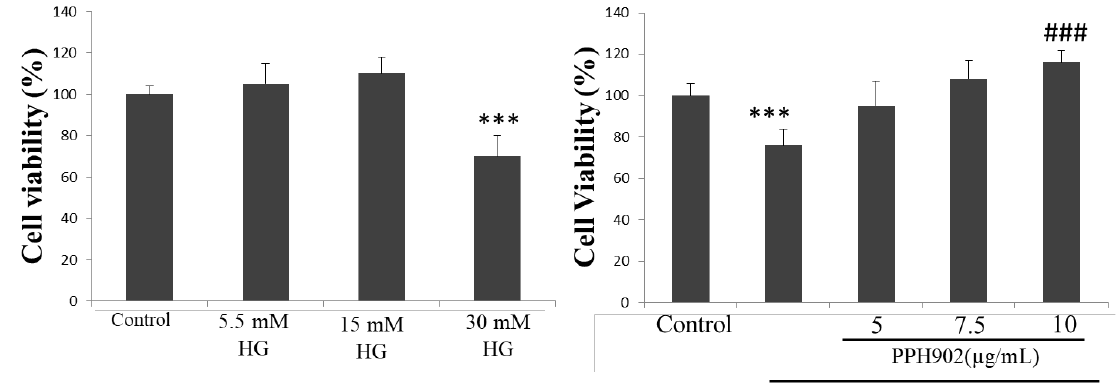
Figure 5. PPH902 on the effect of HG on C2C12 cells. MTT cell viability assay shows the effect of high glucose on cell viability of C2C12 cells. *** p < 0.001 indicates significant difference with respect to control groups and ### p < 0.001 indicates significance difference with respect to the high glucose challenge groups.